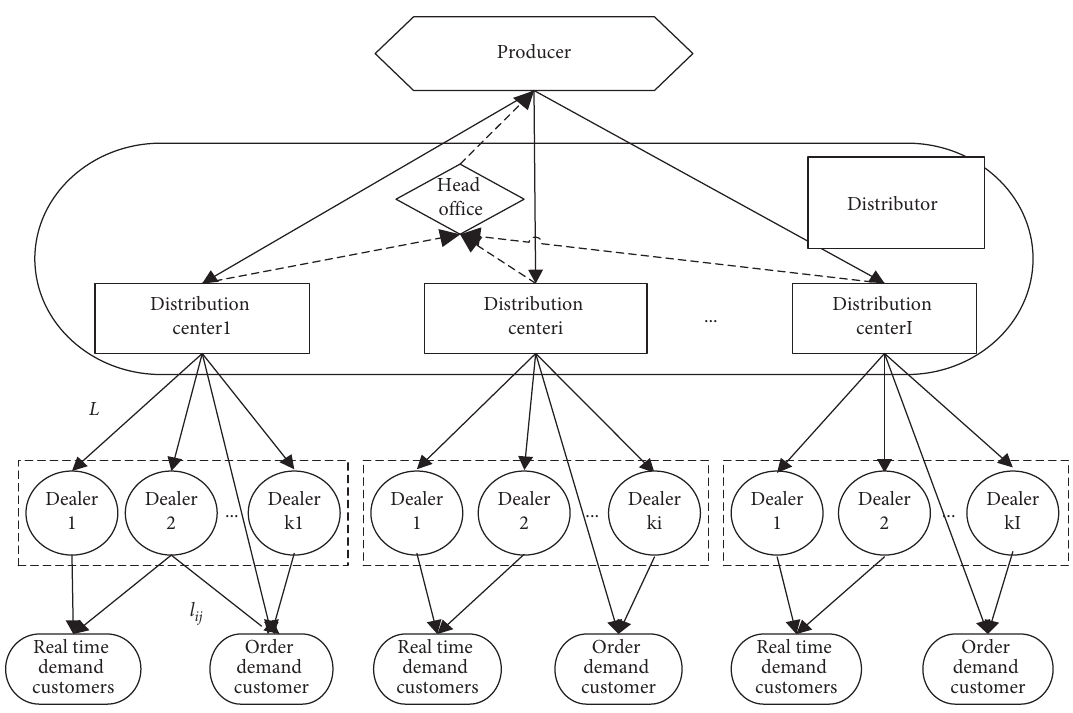
Figure 1: Structure of the bilevel distribution system.